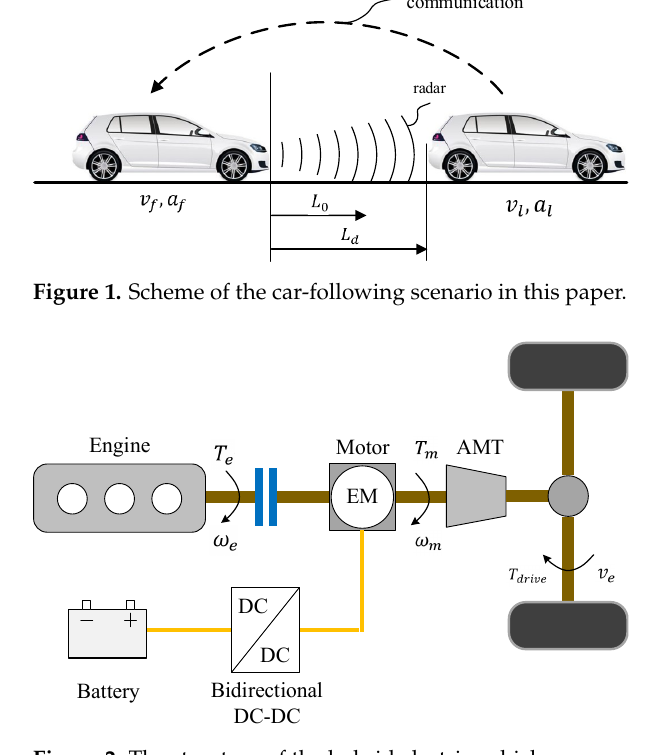
Figure 2. The structure of the hybrid electric